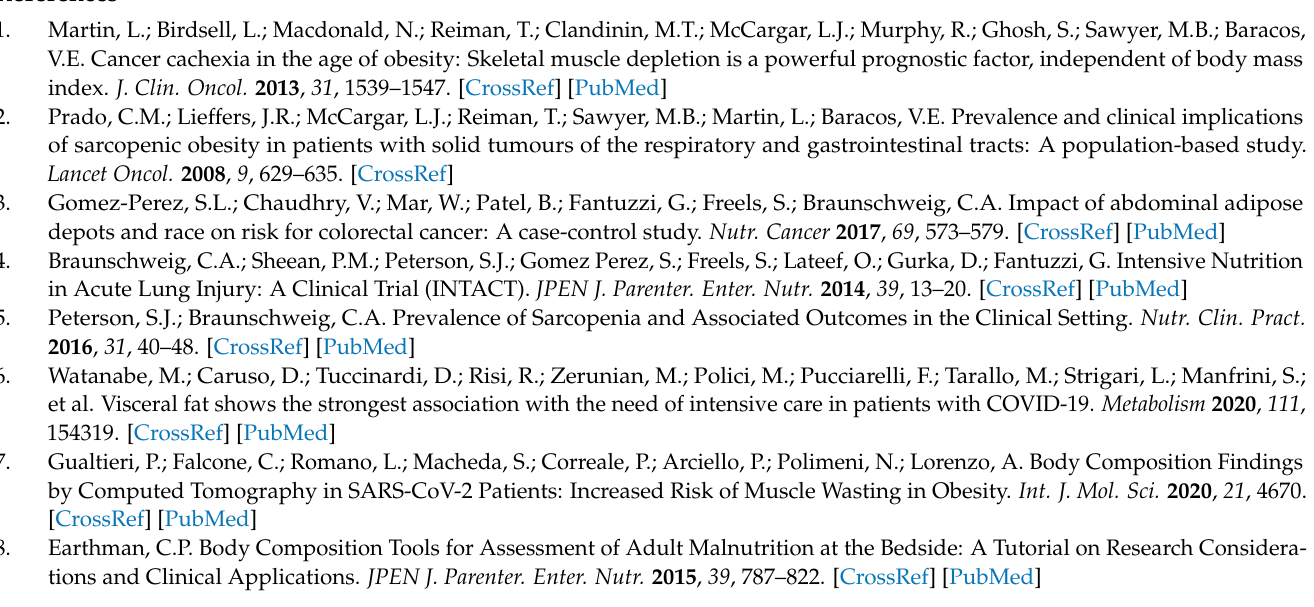
categories; Table S3: DSC by BMI; Table S4: Bland–Altman and proportional bias statistics for females; Table S5: Bland–Altman and proportional bias statistics for males; Table S6: Bland–Altman and proportional bias statistics for Black race/ethnic category; Table S7: Bland–Altman and proportional bias statistics for White race/ethnic category; Table S8: Bland–Altman and proportional bias statistics for Others race/ethnic